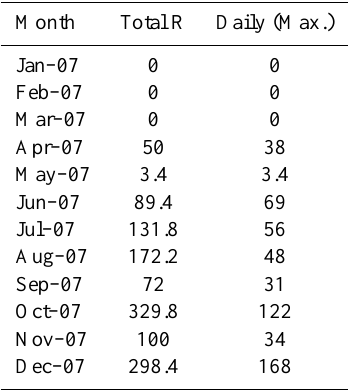
Fig. 2. Wind rose for the month of October showing a NE wind component. Table 1. Observed Precipitation intensities at NLC. Rain Rates (R) are in mmhr − 1